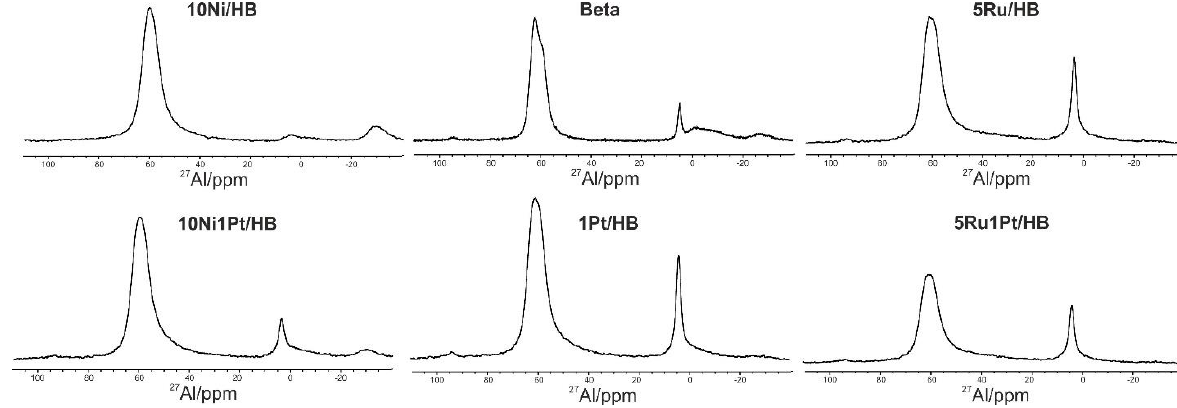
Figure 6. 27 Al NMR spectra of the studied zeolites.